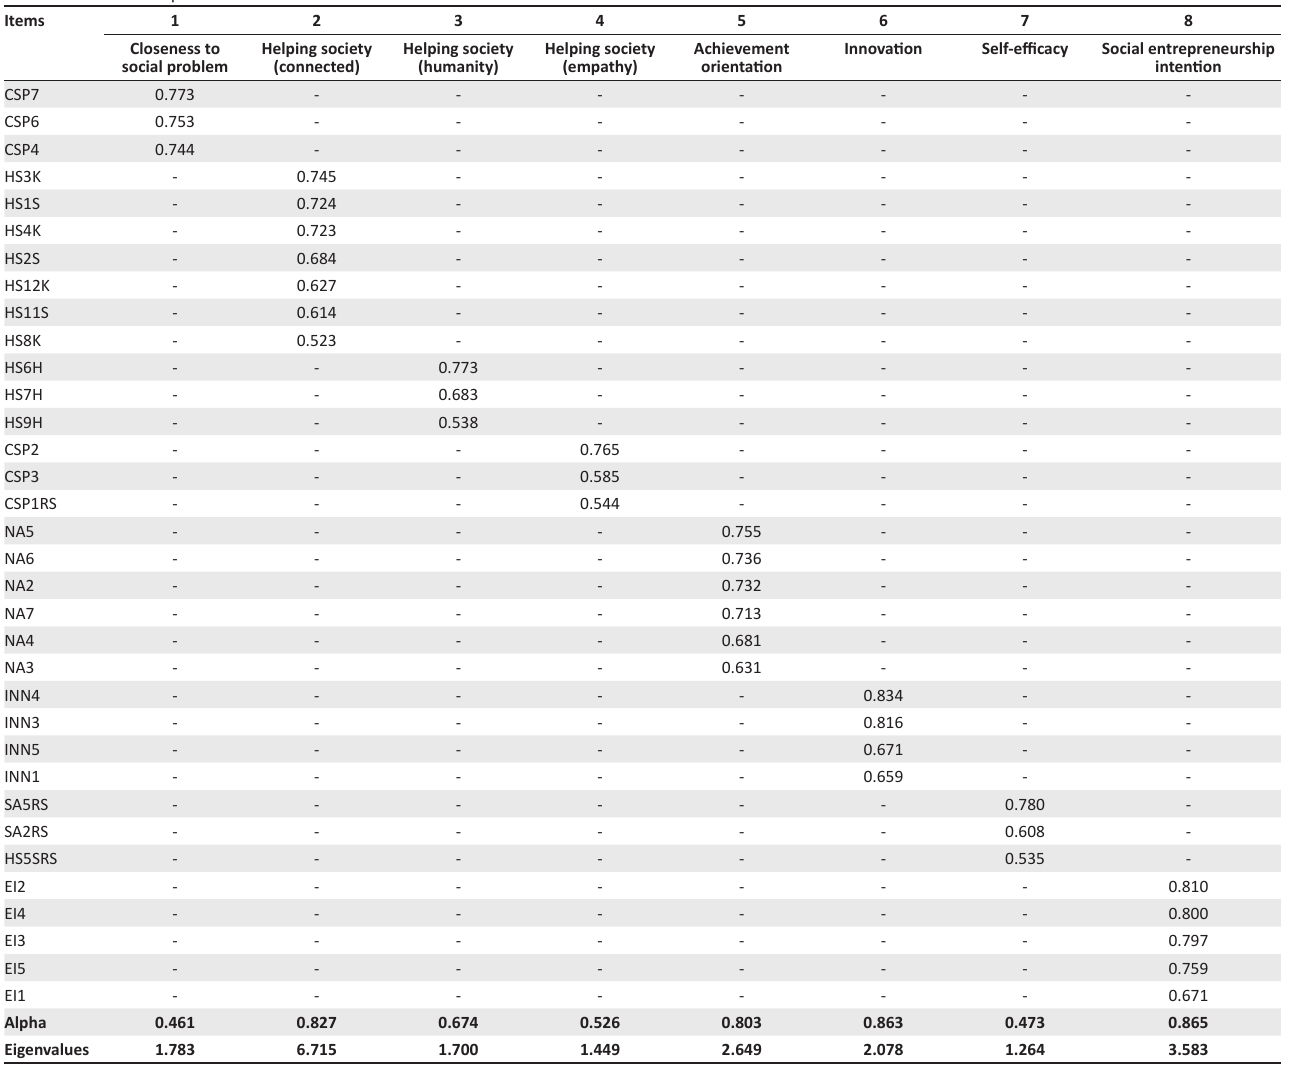
TABLE 1: Rotated component matrix.